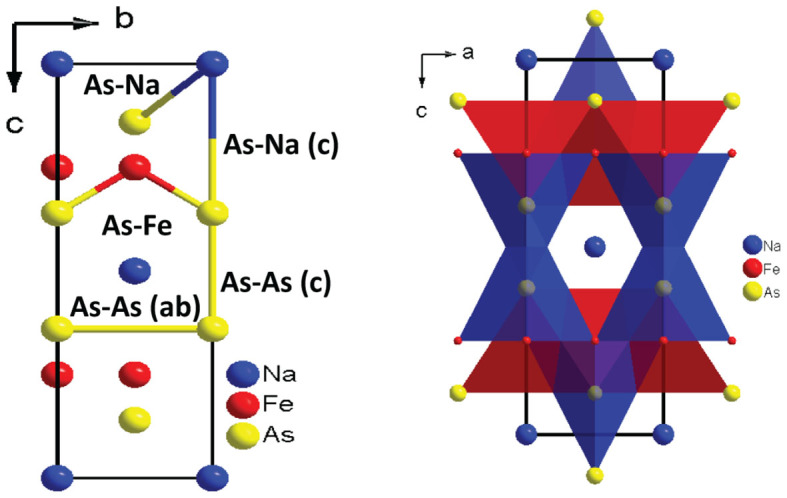
(a) ThCr2Si2-type crystal structure of NaFe2As2 showing the different interatomic distances and (b) ThCr2Si2-type crystal structure of NaFe2As2 with As atoms in 5-fold coordination.